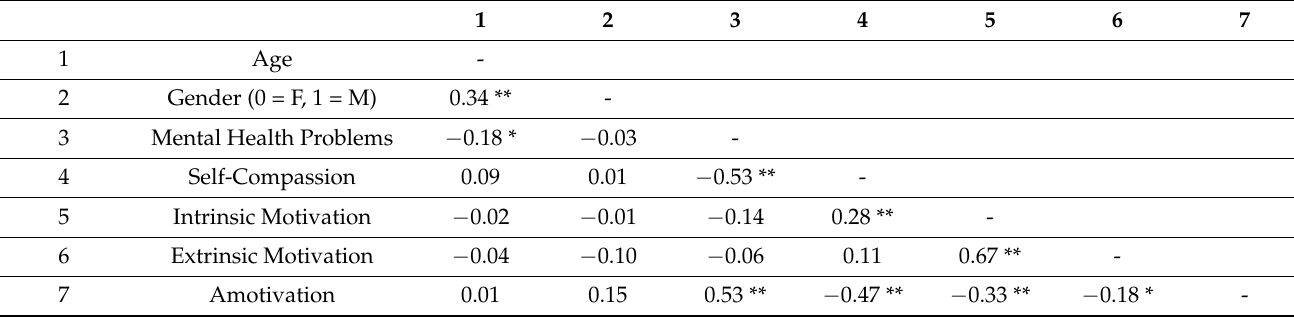
Table 2. Correlations between mental health problems, mental health shame, self-compassion and motivation in Japanese